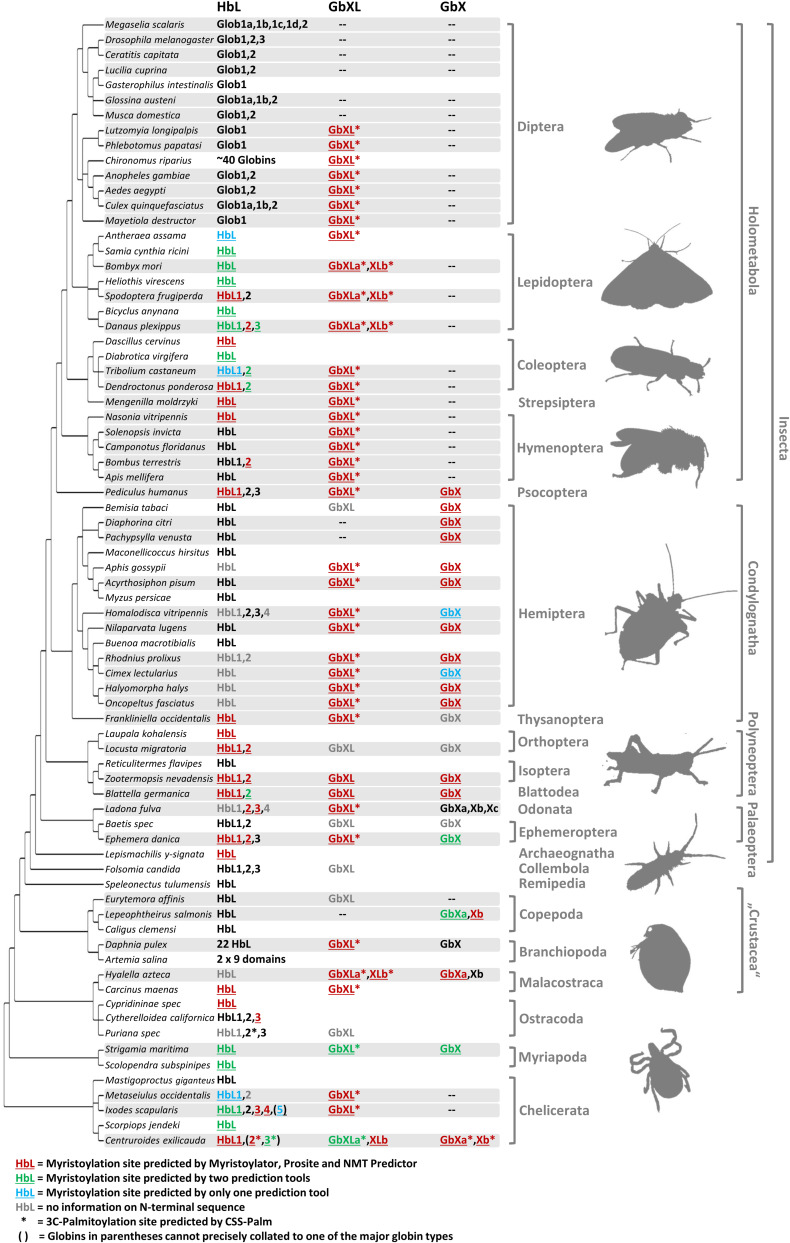
Different globin lineages are present in different arthropod taxa. The organismal phylogeny of arthropods was taken from Misof et al. (2014). Shading indicates taxa with available genome data. Globin sequences containing predicted protein acylation motifs are colored and annotated by underlining (N-myristoylation) and asterisks (3C-palmitoylation). Globins with uncertain N-terminal sequences are shown in gray. Note the following for the designation of the HbL variants: within Diptera, only the name “Glob1” designates putative orthology to the Glob1 gene of Drosophila melanogaster (Burmester and Hankeln, 1999), as defined by phylogenetic tree reconstruction. Closely related paralogues of Glob1 are named “Glob1 a, b, c” etc. Outside Diptera, all gene variants have been designated by “HbL” and numbering of paralogues does not indicate orthology. The comparatively rare cases of GbX and GbXL gene duplicates have been assigned as “a, b, c”.